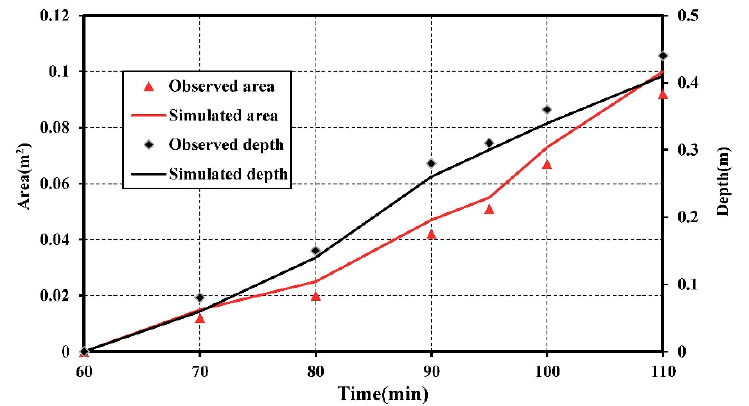
Figure 6. The observed and simulated seawater contamination plume area and maximum vertical pollution depth over time for scenario